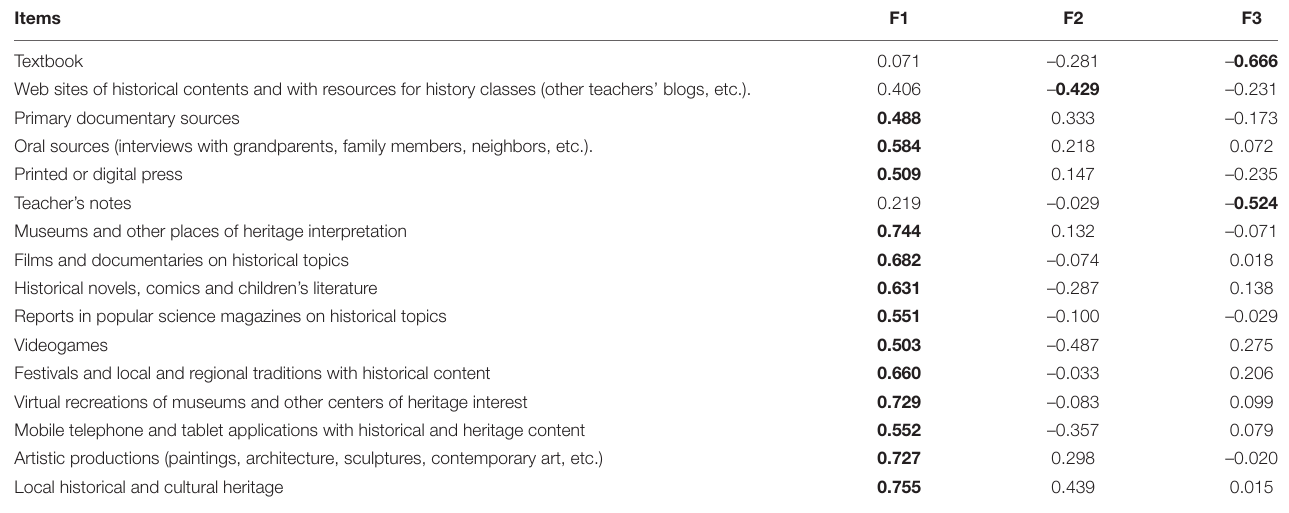
TABLE 3 | Principal component